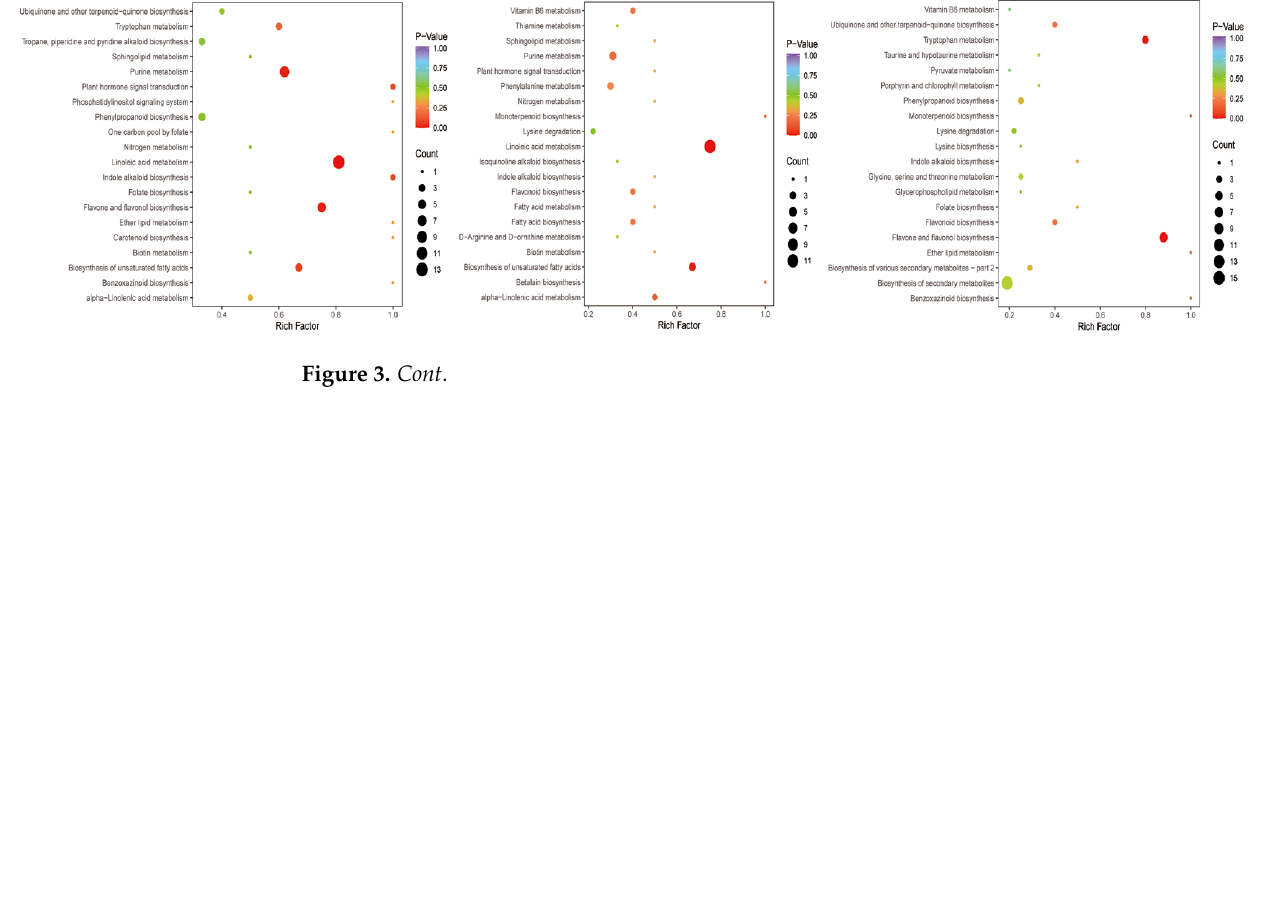
Figure 3. ( A – C ) KEGG enrichment plots of differential metabolites from different germplasms comparison groups, ( A ) JL vs . GK, ( B ) JZ vs . GK, ( C ) JZ vs . JL, ( D ) D istribution of differential metabolites from different germplasms P. cyrtonema linoleic acid and unsaturated fatty acid biosynthetic pathways, grey font represents non - detected metabolites, solid arrows represent individual reactions, and the dashed arrows indicate conversions with multiple steps catalysed.